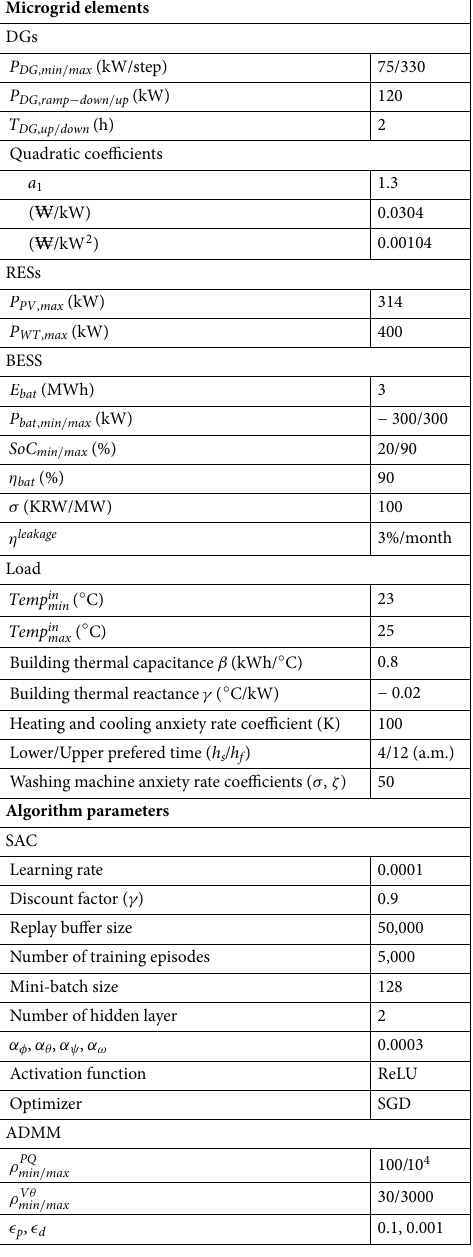
Table 2. The Gasa island EMS solution simulation technical specifications and